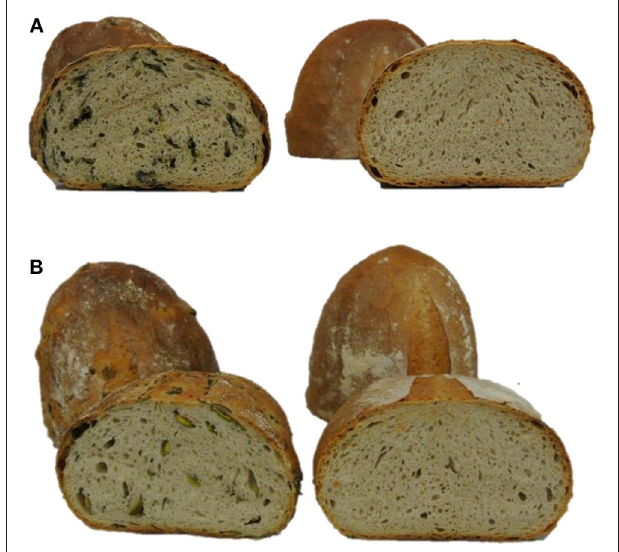
FIGURE 2 | Breads fortified with plant material and reference bread. (A) Pea microgreen bread (left) and reference bread (right); (B) Lupin microgreen bread (left) and reference bread